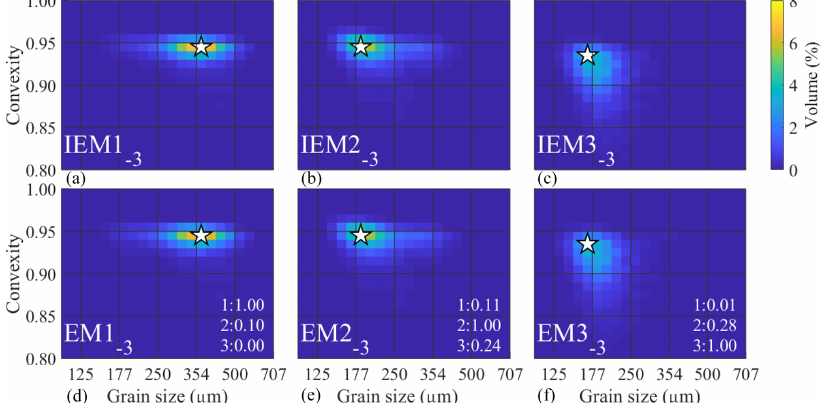
Figure 4. Input endmembers (a–c) and determined endmembers (d–f) for the ConD2d 3EM_nonoise dataset, with R 2 values denoting the fit between them (lower right corners). The first R 2 value indicates the correlation of the determined endmember with IEM1 − 3 , the second with IEM2 − 3 , etc. White stars mark the modes of the